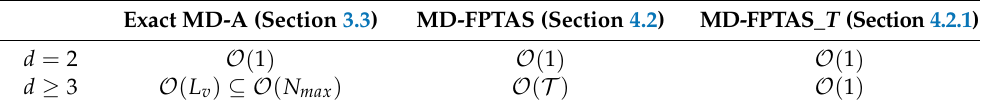
Table 1. Complexity C of the dominance checks. Exact MD-A (Section 3.3) MD-FPTAS (Section